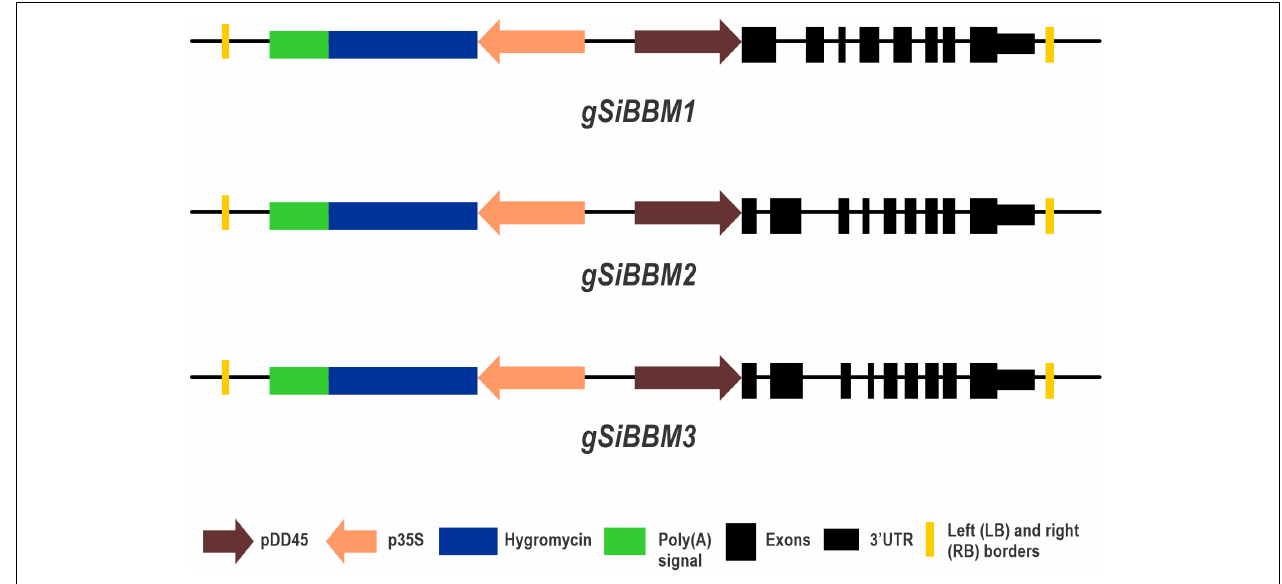
FIGURE 2 | gSiBBM constructs. A diagrammatic figure of the three genomic SiBBM constructs used in this study. Transgenic plantlets were selected with hygromycin driven by the CaMV 35S promoter. SiBBM1 contains 8 exons, while SiBBM2 and SiBBM3 have 9 exons. The constructs are not drawn to